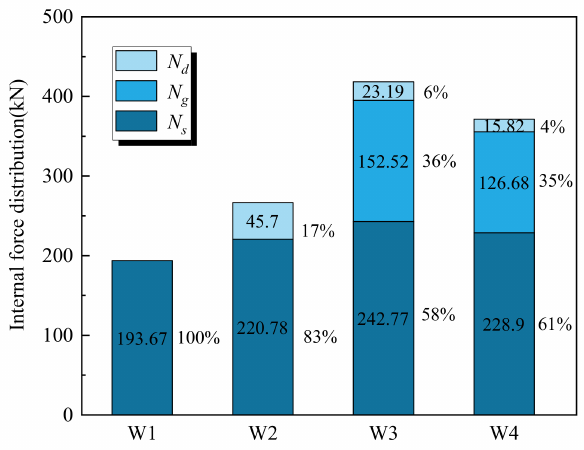
Figure 15. Contribution proportions of